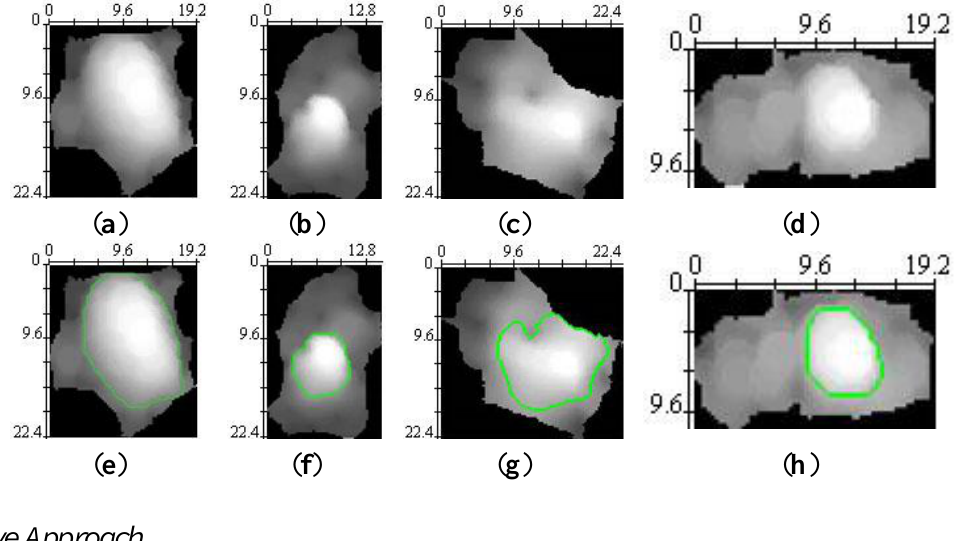
Figure 7. Examples of 2D sediment particle boundary delineation using Active Contour Without Edges. ( a – d ) DSM segments of particles of different size, (a) Cobble, (b) Coarse gravel, (c) Coarse gravel in a complex neighborhood, (d) Medium gravel. ( e – h ) Results of Active Contour Without Edges. The scalar unit in (a–h) is in